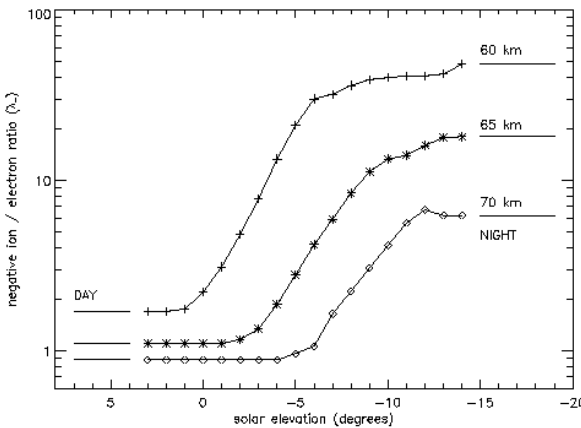
Fig. 12. Estimated variation of the concentration ratio of negative ions to electrons during evening